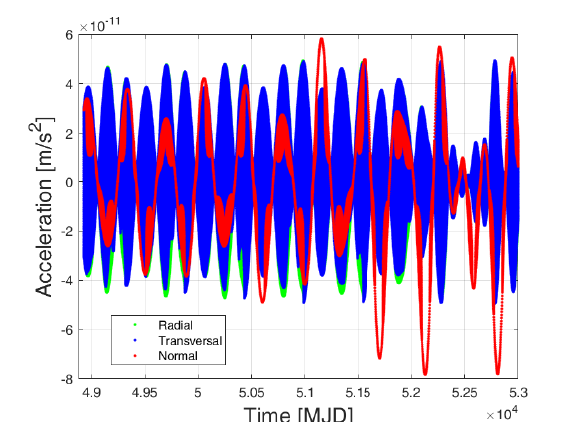
Figure 8. Perturbing accelerations on LAGEOS II due to the Yarkovsky-Schach effect over a time span of about 11.2 years. These results have been obtained by our simplified thermal model.